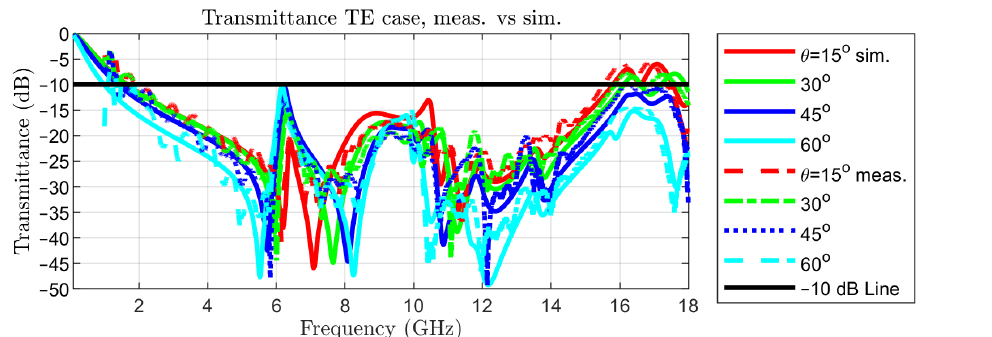
Figure 10. Transmittance in oblique incidence of TE waves: simulated vs.